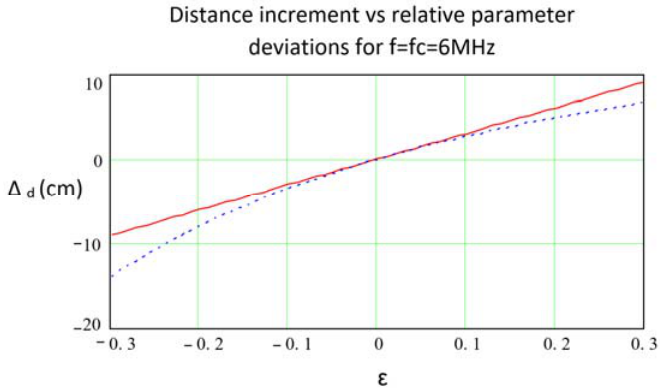
Figure 5. Phase stability computed from Equation (9) (blue/dashed) and from the approximated expression in Equation (14) (red/solid) as a function of ε = Δ GBWP / GBWP = Δ Re / Re = – Δ Ce / Ce , obtained for an OA OPA847, Rf = 22 K Ω , Cf = 1.2 pF, Ce = 18.7 pF and f = f C = 6 MHz.